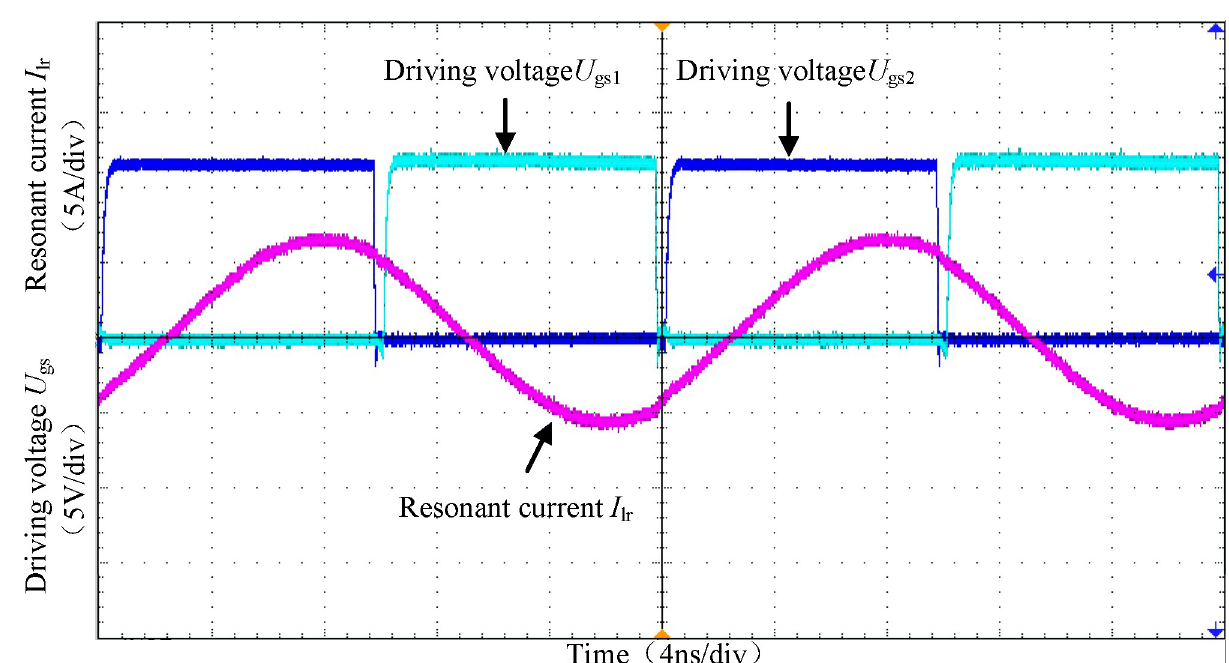
Fig 27. The waveforms of driving voltages and resonant current.